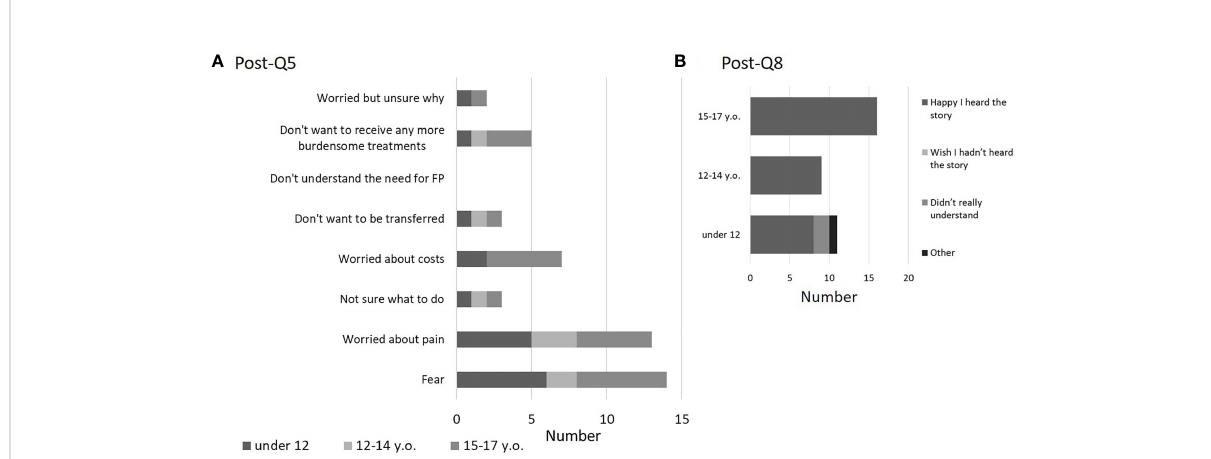
FIGURE 5 Questionnaire results after FP explanation (post-Q5 and 8). Key concerns about FP involved fear and pain, followed by fi nancial concerns. No age-related differences were seen in these results ( A : post-Q5). After the explanation, all children showed a positive reaction. The results also included patients (5 girls) who did not receive FP and the patients (one girl and boy) who responded that they did not wish to undergo FP ( B : post- Q8). Of these 36 patients, 11 were <11 years old (Group A), 9 were 12 – 14 years old (Group B), and 16 were 15 – 17 years old (Group